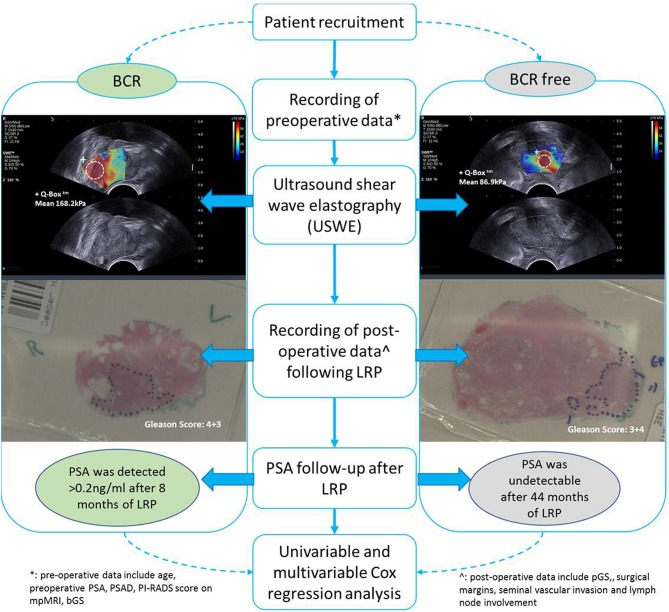
Examples of BCR and BCR-free patients in comparison of SWE and clinicopathology data.